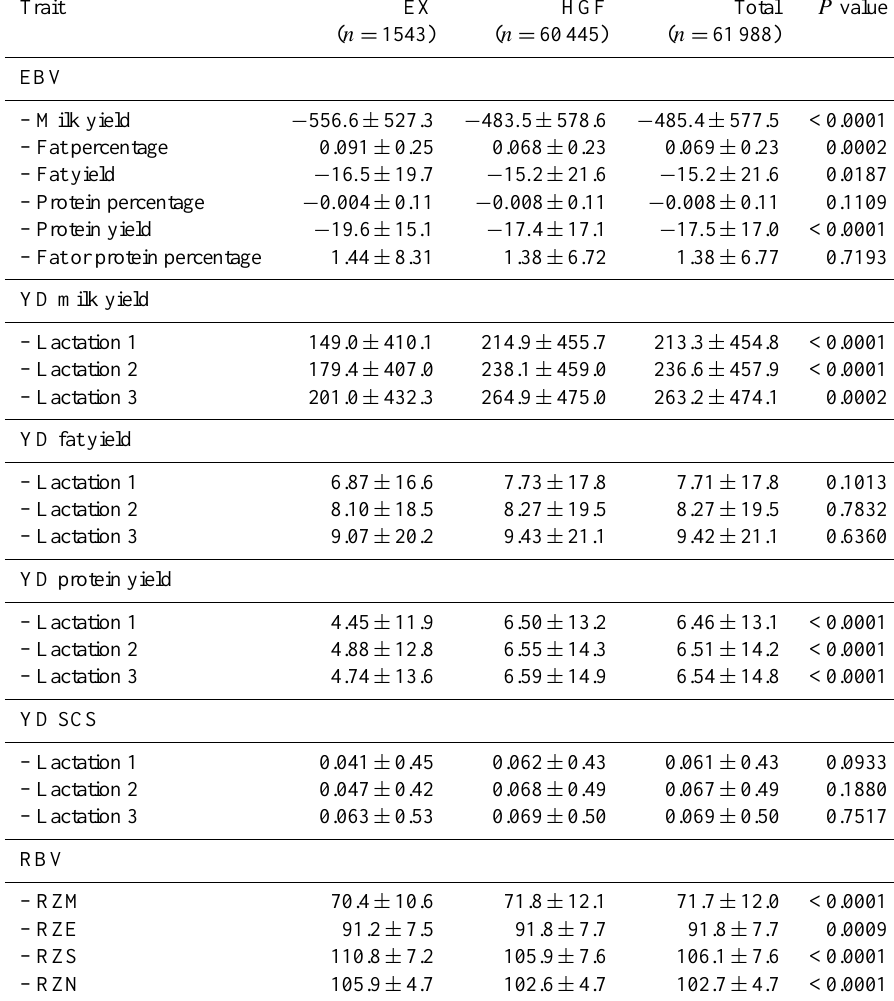
Table 2. Least-square means and standard deviations of the traits analyzed including daughter yield deviations (YDs), estimated breeding values, and relative breeding values (RBVs) of exceptional cows (EX) and contemporary herdmates (HGF) for milk performance (RZM), somatic cell count (RZS), type (RZE), and functional longevity (RZN) as well as P values for trait differences among EX and